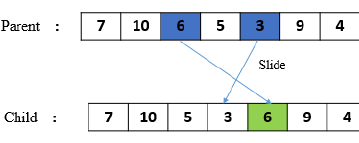
Fig. 6 An illustration for slide operation